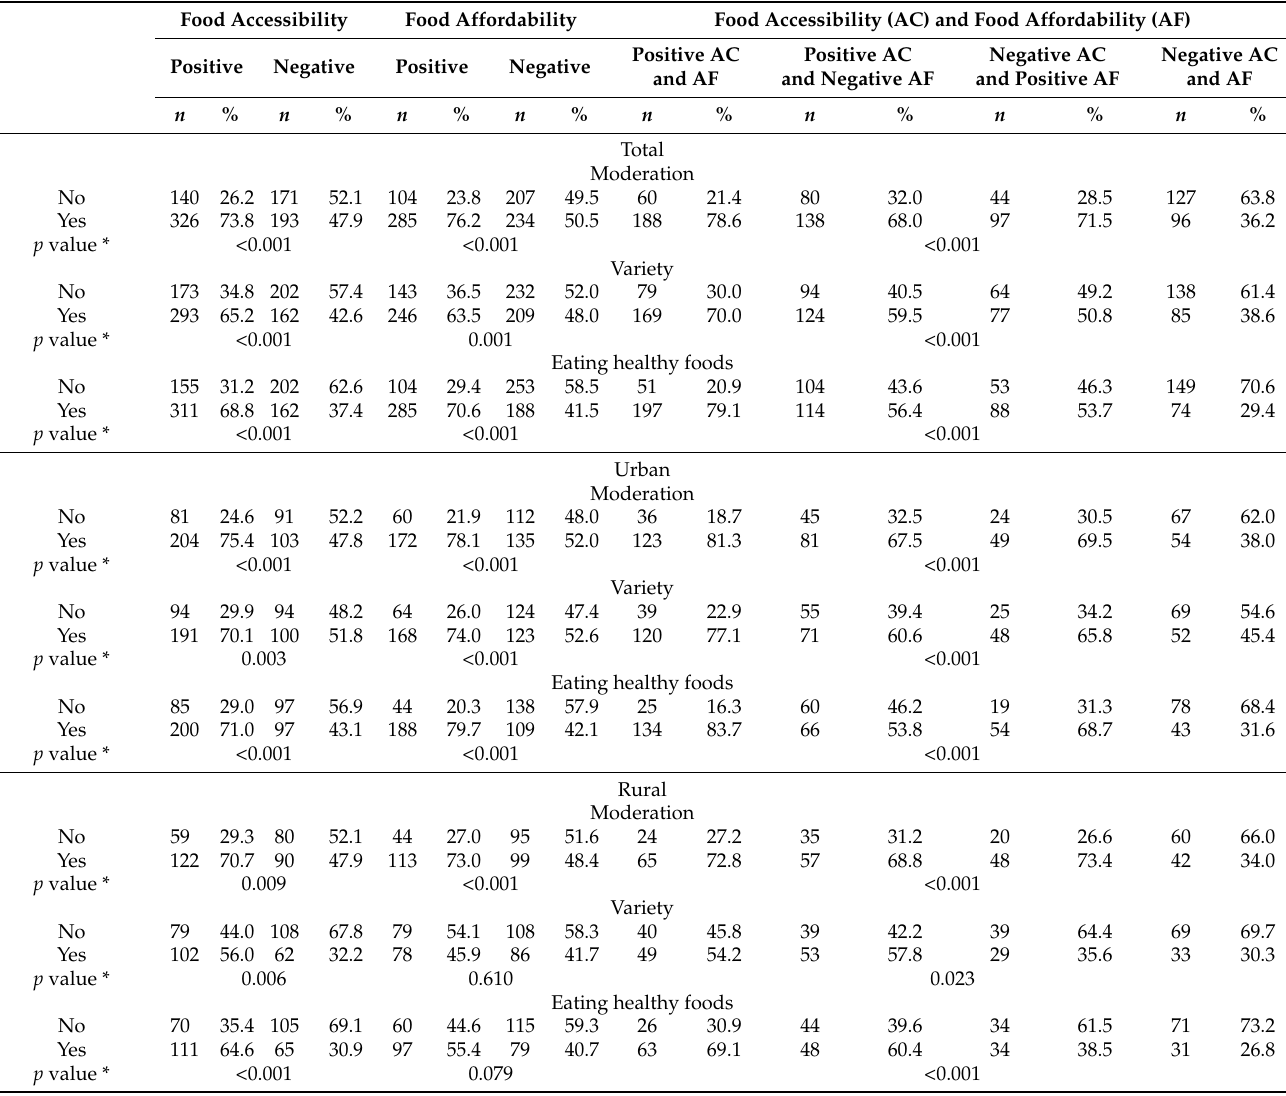
Table 4. The relationship of perceived food environment with healthy eating